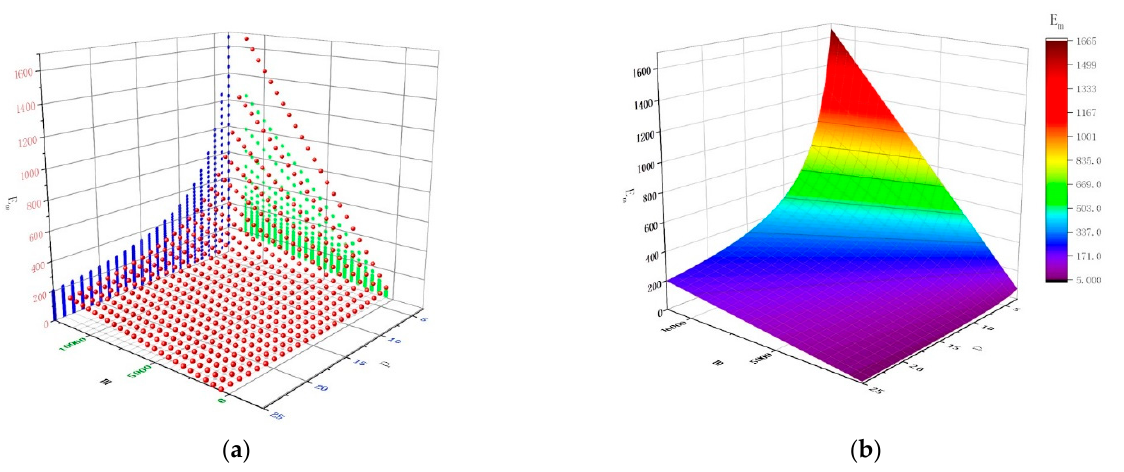
Figure 6. Scatterplot ( a ) and the fitted surfaces ( b ) of the effective sample subspace values E m with the values of m (0 < m ≤ 11500) and p (3 ≤ p ≤ 25).